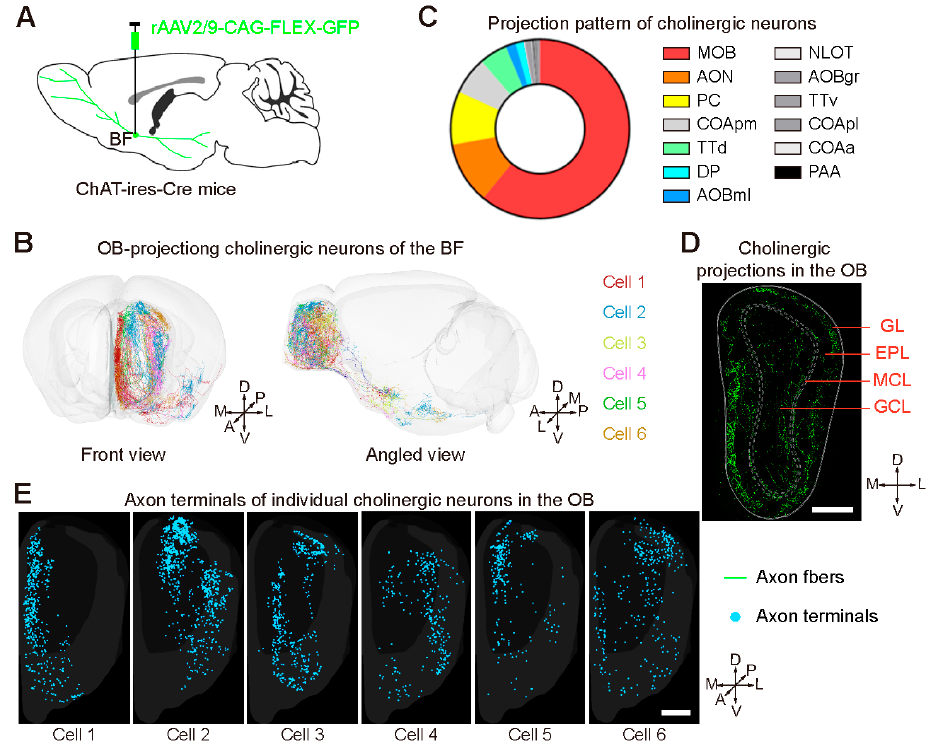
Figure 6. Axonal projections of the cholinergic neurons of the BF. ( A ) Strategy for labeling the cholinergic neurons of the BF using rAAV2/9-CAG-FLEX-GFP. ( B ) Six OB-projecting cholinergic neurons were reconstructed from the whole-brain database and are shown in different colors. ( C ) Distribution of the axon terminals of the cholinergic neurons in the primary olfactory areas. MOB, main olfactory bulb; COApm, posteromedial part of the cortical amygdalar nucleus; TTd, dorsal part of the taenia tecta; DP, dorsal peduncular cortex; AOBml, mitral cell layer of the accessory olfactory bulb; NLOT, nucleus of the lateral olfactory tract; AOBgr, granular cell layer of the accessory olfactory bulb; TTv, ventral part of the taenia tecta; COApl, posterolateral part of the cortical amygdalar nucleus; COAa, anterior part of the cortical amygdalar nucleus; PAA, amygdalopiriform transition area. ( D ) Representative image of fluorescently labeled cholinergic axon fibers in the OB. GL, glomerular layer; EPL, external plexiform layer; MCL, mitral cell layer; GCL, granular cell layer. ( E ) Axon terminals of individual cholinergic neurons in the OB. Scale bars, 500 µ m in ( D , E ). Taken together, our results indicated that the M/TCs and GCs share similar input sources with different distribution patterns. Figure 7 summarizes the major input regions of the M/TCs and GCs in schematic form.